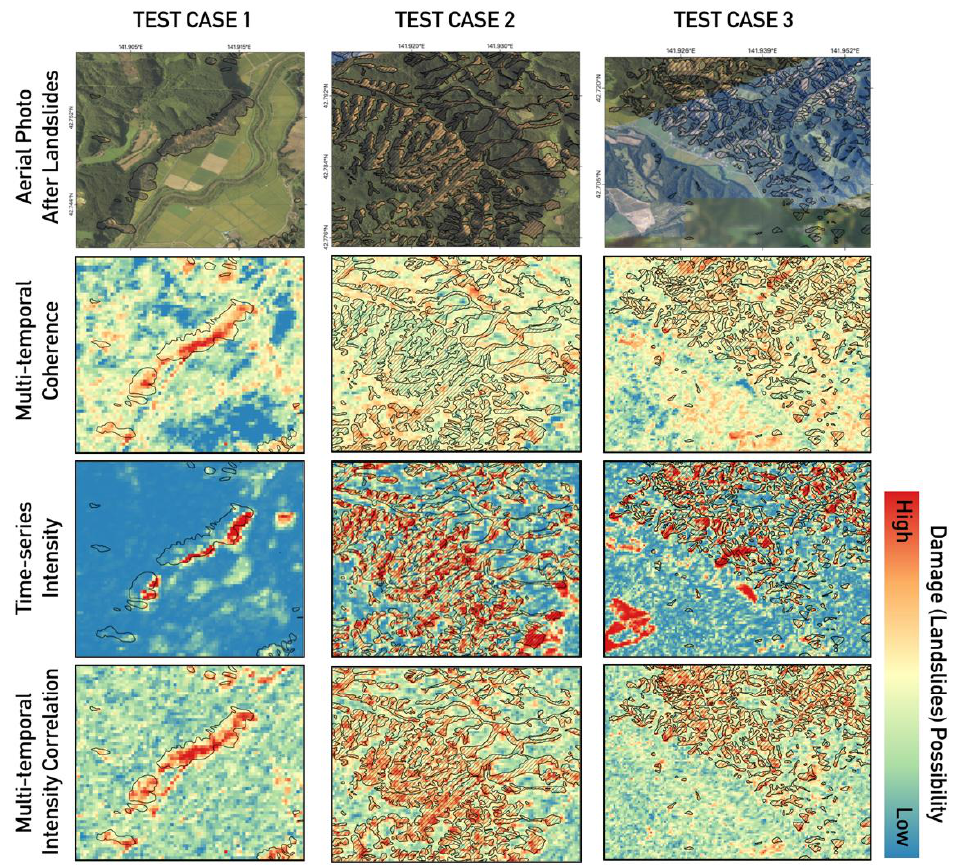
Figure 7. Results of damage (landslides) detection algorithms for multi-temporal approaches. All results are rescaled to the range 0 to 1 for visualization. Red color indicates the high possibility (or large difference from reference product) of event-induced changes (landslides). Black polygons depict the landslide area extracted from aerial photos.